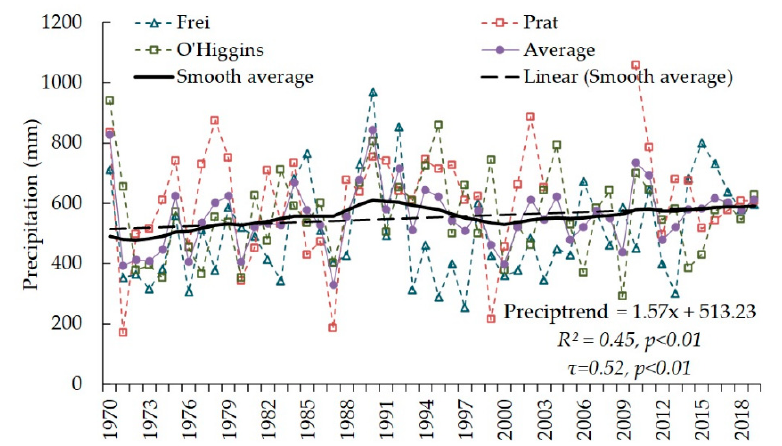
Figure 2. Annual total precipitation registered at Frei, Prat, and O’Higgins stations. Purple curve-dots and black curves are, respectively, the average and exponential filter of the three stations. τ is the Kendall’s tau rank correlation applied to the linear trends (Equation (11)).